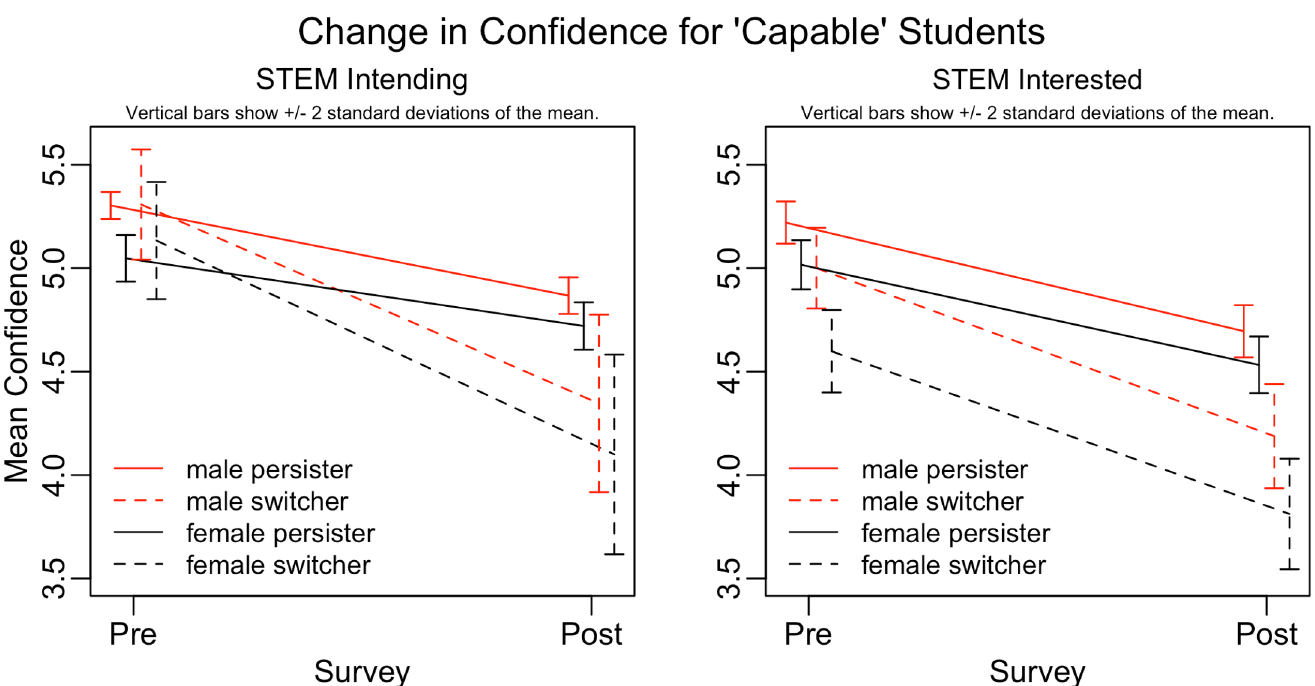
Fig 4. Change in student mathematical confidence at the beginning of the Calculus I semester (pre-survey) and at the end of the semester (post-survey) separated by career intentions, gender, and persistence status. [N =